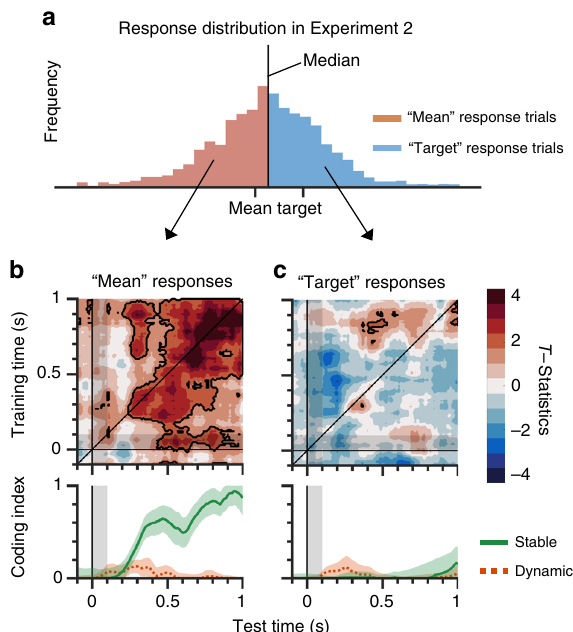
Fig. 5 Median-split analysis from Experiment 2. a We split a response distribution in the VO condition of Experiment 2 by its circular median. As a result, one set was closer to the mean orientation, while the other set was closer to the target orientation. The SO decoder was built and generalized to the two sets, separately. b Reconstruction from the mean-close responses showed stable coding. c Reconstruction from the target-close responses showed no evidence of either stable nor dynamic coding. Top, the x - and y -axes show the time of test and training sets after stimulus onset, respectively. Colors represent the t -statistics. Black areas show signi fi cant modulation over time, determined by a one-sided Monte Carlo randomization test, p < 0.05. Bottom, the x -axis shows the time after stimulus onset. The y -axis shows the magnitude of stable and dynamic coding. Green lines show stable coding. Red dotted lines show dynamic coding. Shaded areas represent ± 1 bootstrapped standard error. SO same orientation; VO varied